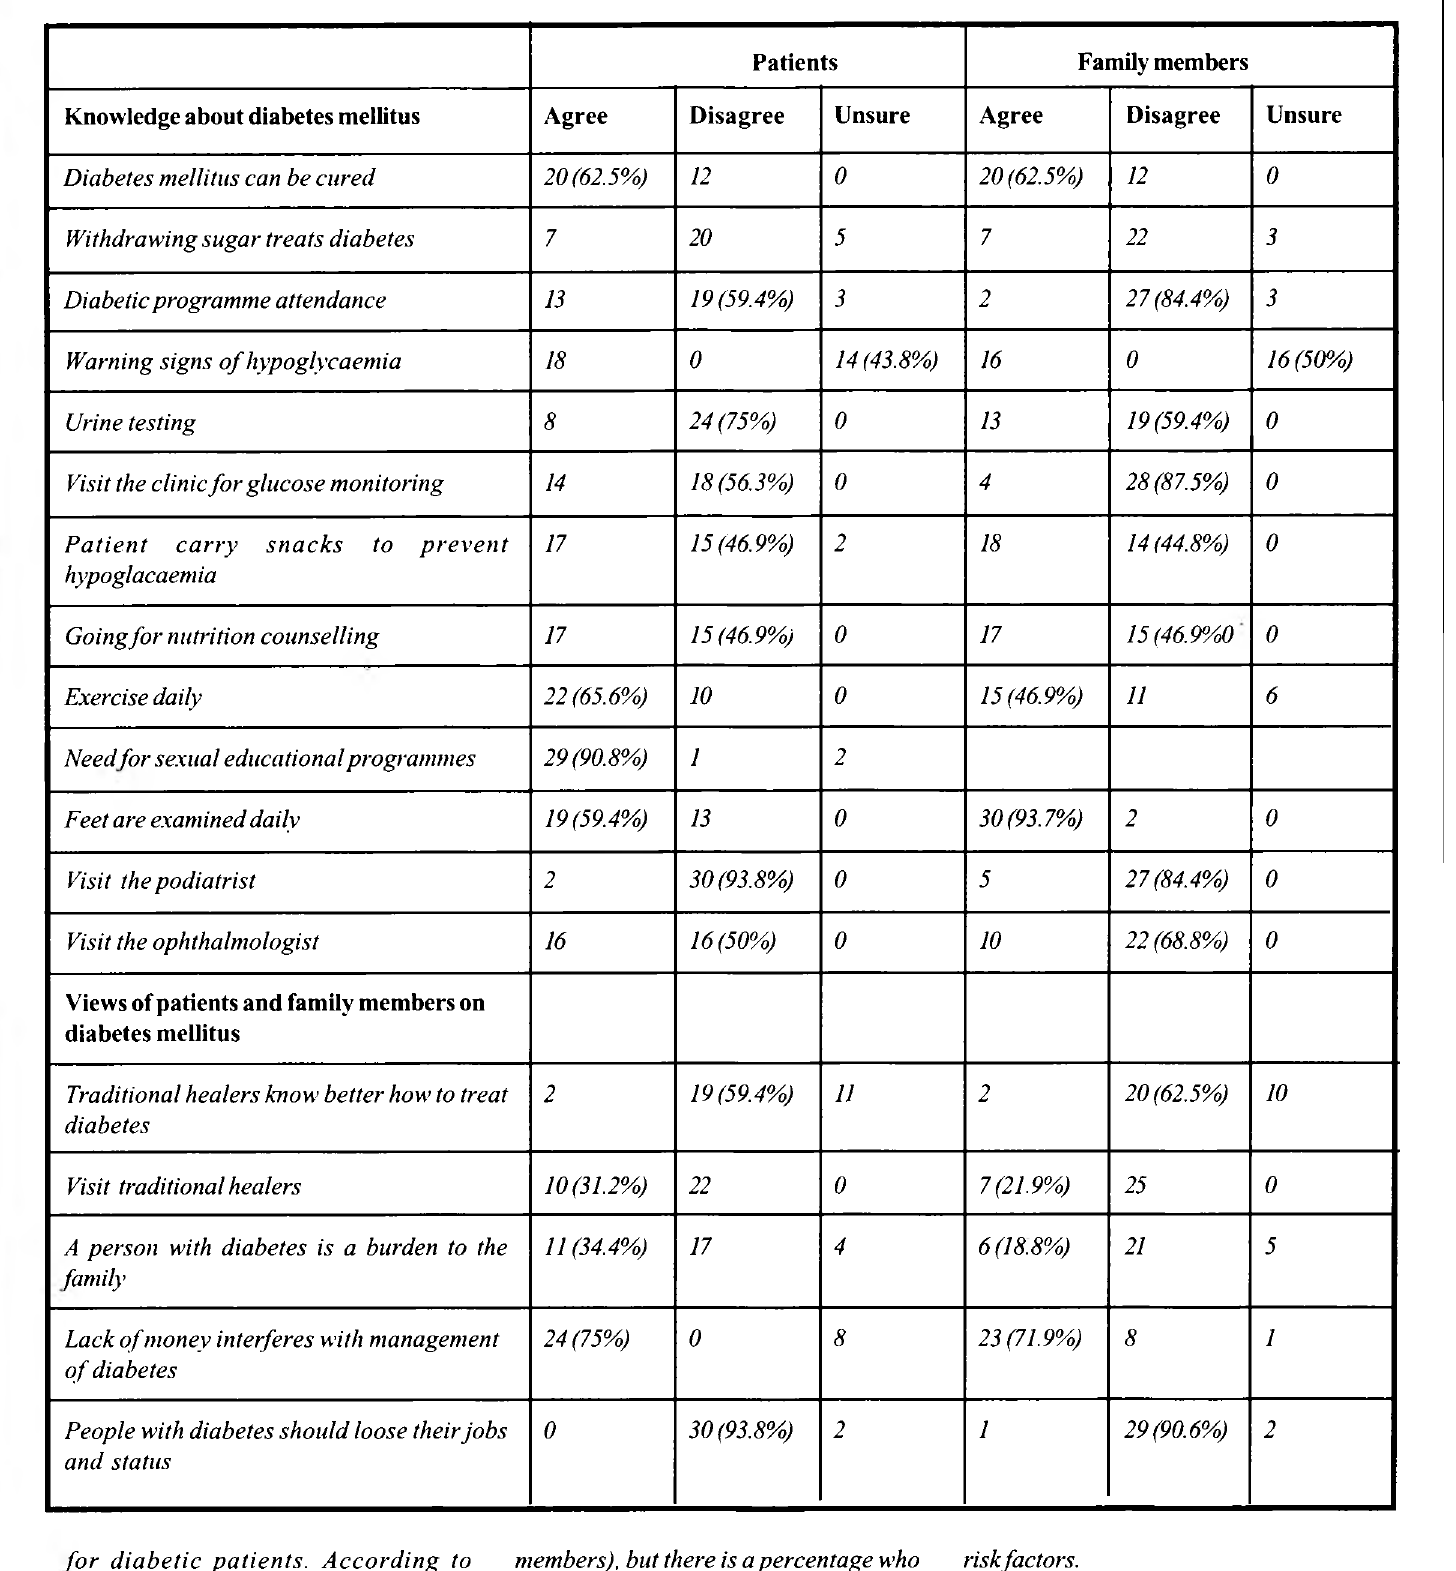
Table 1: Findings on knowledge and views of patients and family members about diabetes